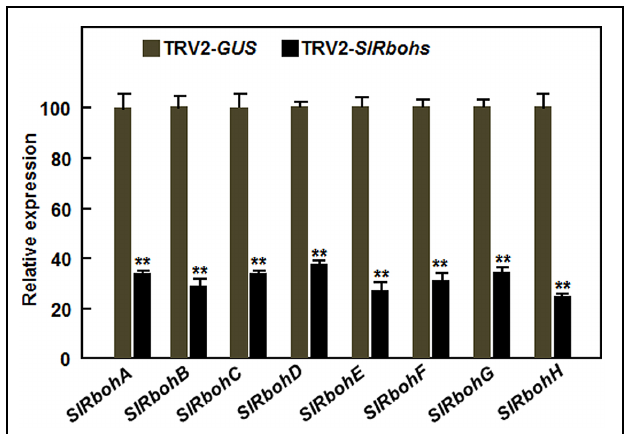
FIGURE 3 | Silencing efficiency of the SlRboh genes in silenced plants. Two-week-old plants were infiltrated with agrobacteria harboring TRV2- SlRbohA-H or TRV2- GUS and leaf samples were collected at 3 weeks after VIGS infiltration. The silencing efficiency was calculated by comparing the transcript levels of the SlRboh genes in TRV2- SlRbohs -infiltrated plants with those in TRV2- GUS -infiltrated plants, which were set as 1. Data presented are the means ± SD from three independent experiments and ∗∗ above the columns indicate significant differences at p < 0.05